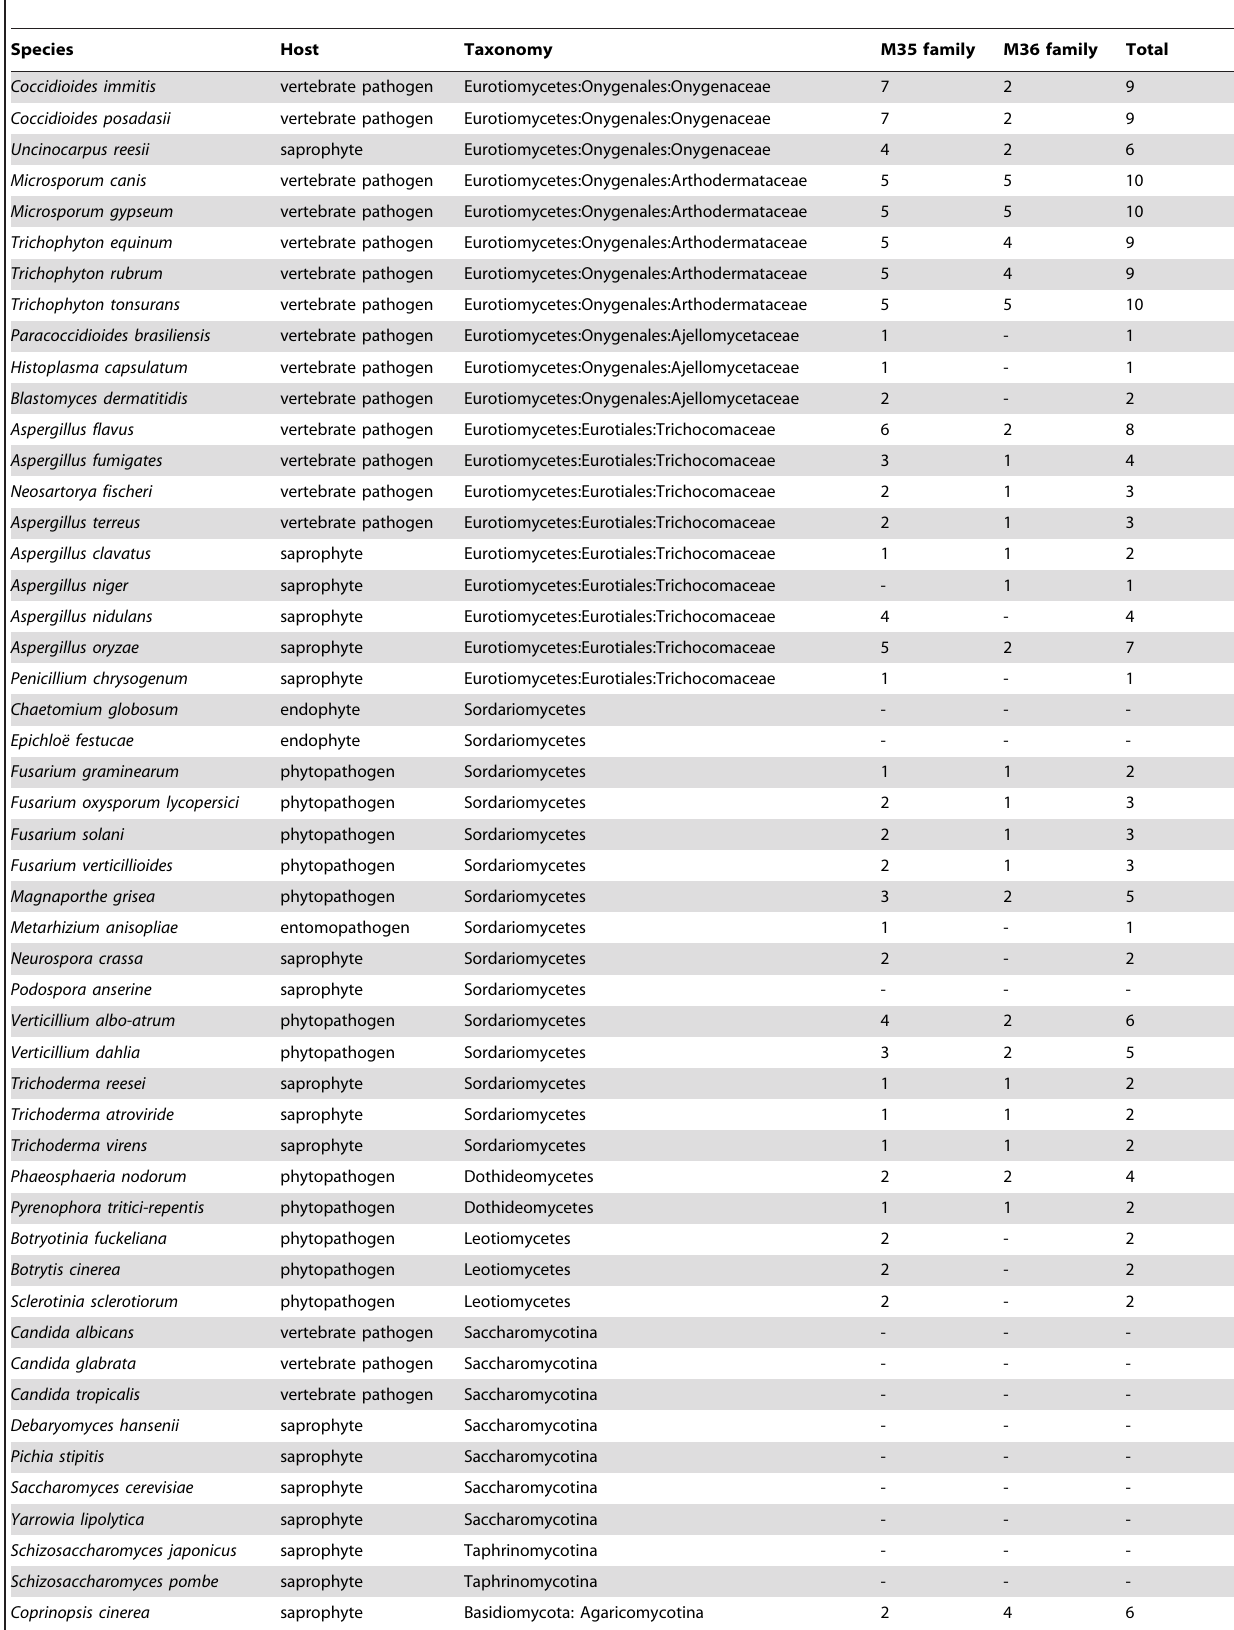
Table 1. Number of both M35 family and M36 family genes in different fungal species.